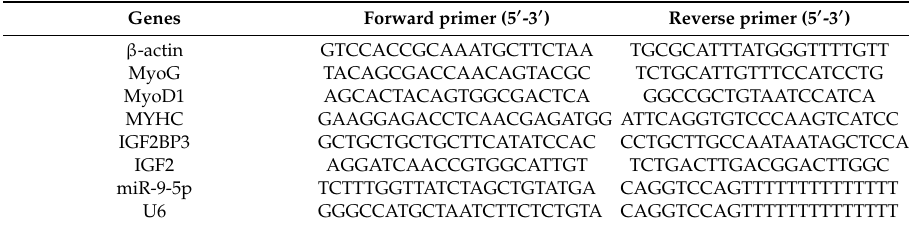
Table 2. Primers used for quantitative real-time